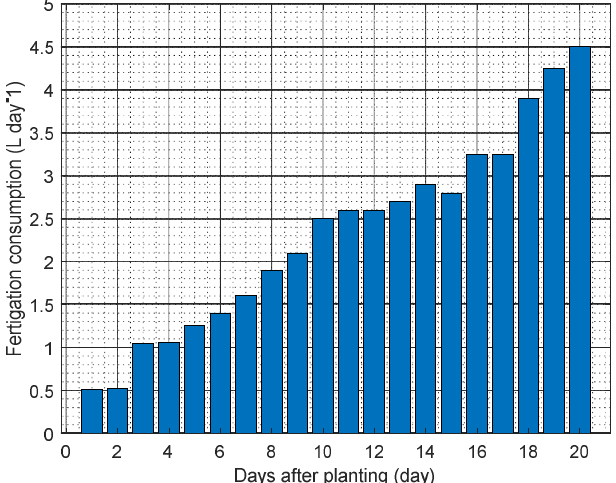
Figure 5. Fertigation consumption during spinach cultivation. Productivity is a key parameter in evaluating yield in plants; applying the hydro- ponic kit can produce yields of spinach of up to 1.34 kg/m 2 . This productivity competes with traditional non-hydroponic farming methods which usually reach 0.91 kg/m 2 [40] and 0.88 kg/m 2 [41]. This suggests that, compared to traditional methods, hydroponic farming provides sufficient circumstances for spinach cultivation. Some of the latest tech- niques to increase productivity in hydroponic agriculture are the application of nanotech- nology-based fertilizers [42], planting pattern setting [43], and the implementation of a light-emitting diode (LED) as artificial light [44]. Recently, the use of vertical farming in hydroponics has also led to an improvement in productivity. This pertains to the reality that increasing global population demand on agricultural land can optimize food output per unit area of agriculture. By farming upward instead of outward, this method tries to limit the amount of interference in conventional agriculture [45]. Figure 6. Cultivation of red and green spinach using a hydroponic kit based on a self-fertigation system. The complete morphological and nutritional characteristics of green and red spinach are shown in Table 1. Based on the analysis, green spinach had a height and fresh weight of 39.55 ± 1.65 cm and 46.03 ± 2.59 g, while red spinach has a height of 21.12 ± 3.99 cm and fresh weight of 15.38 ± 2.1778 g, respectively. These results indicate that green spinach has better growth than red. In terms of nutritional content, green spinach had 130.45 ± 1.38